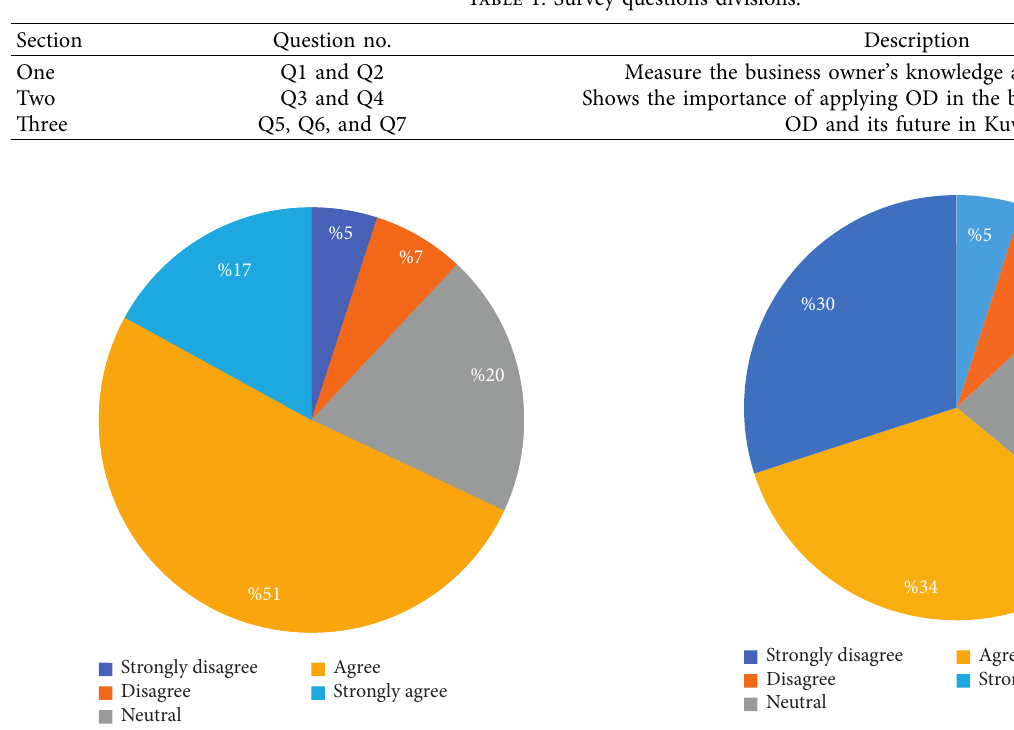
Figure 3: Q1: I think the open data concept is common and I heard about it